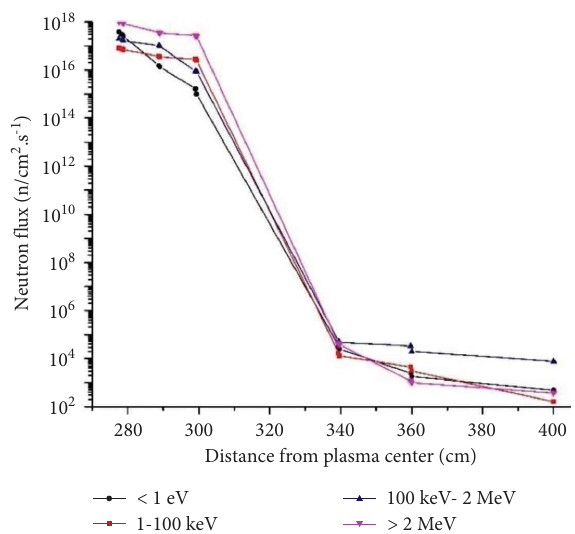
Figure 8: Neutron distribution in depth of HCLL blanket.